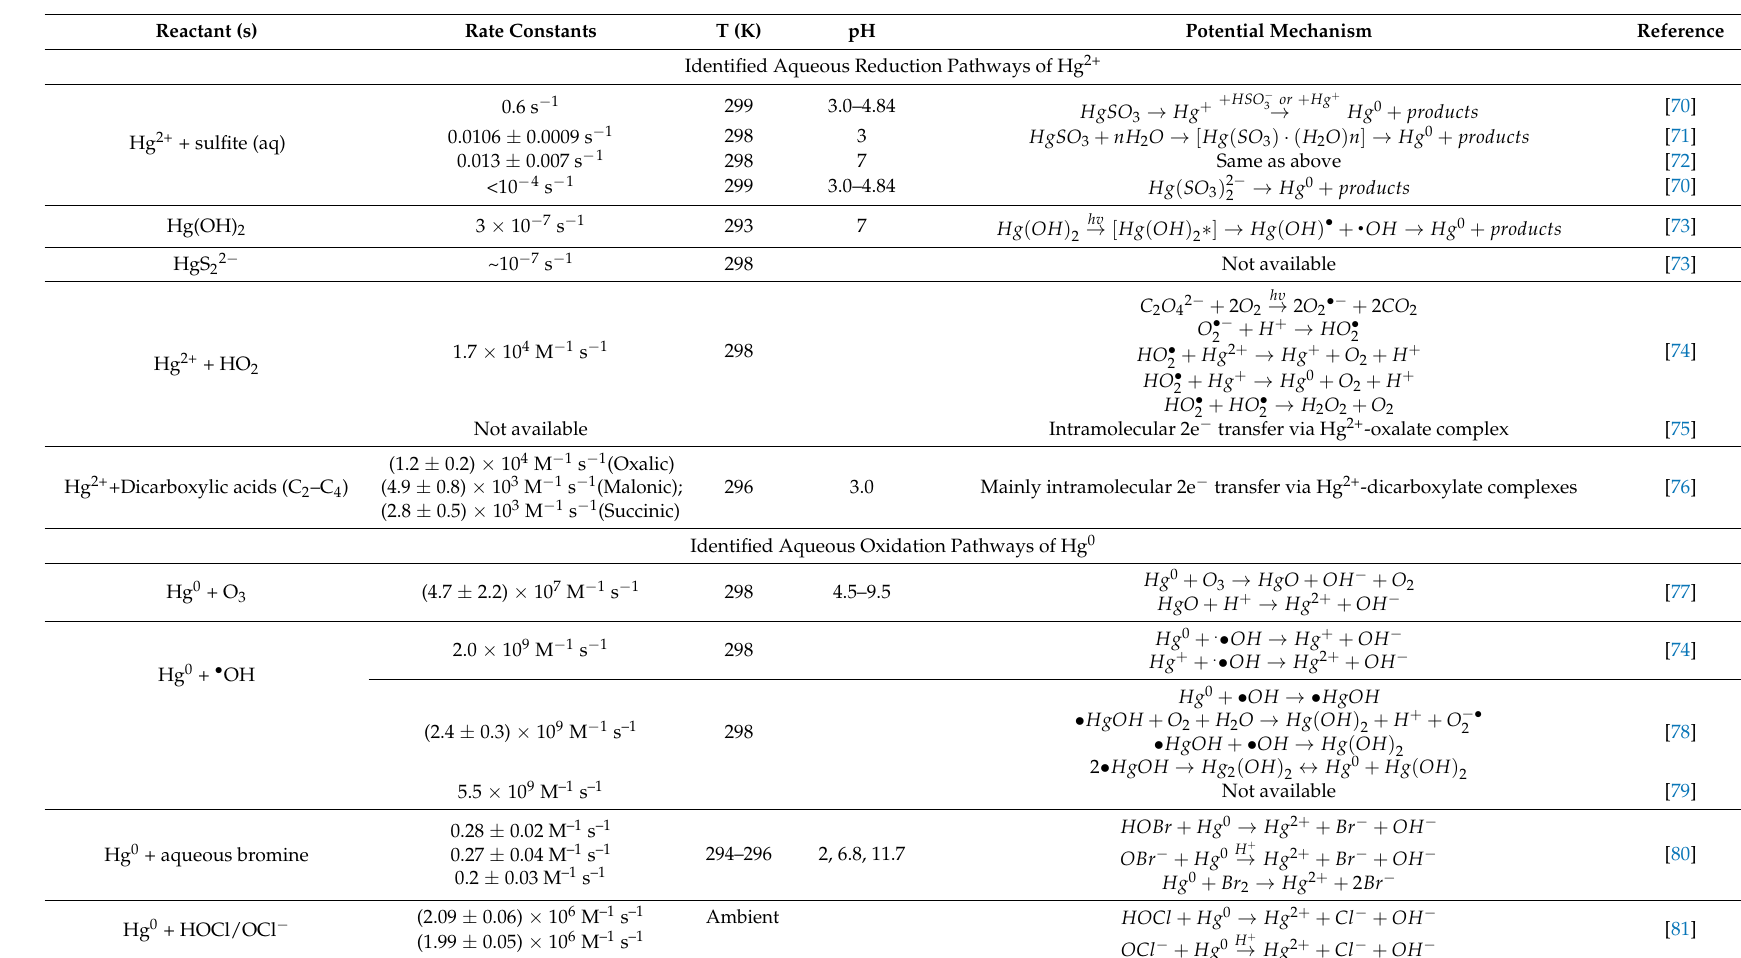
Table 2. Current accumulated knowledge on chemical redox pathways of Hg in the aqueous